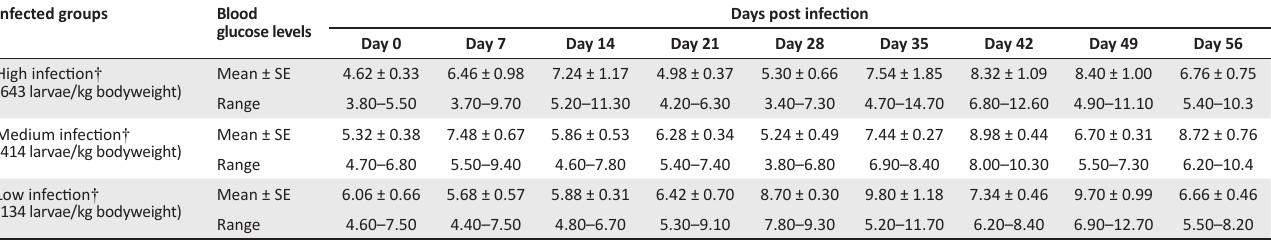
TABLE 2: Mean blood glucose levels (mmol/L) in Nile crocodiles ( Crocodylus niloticus ) experimentally infected with Trichinella zimbabwensis.